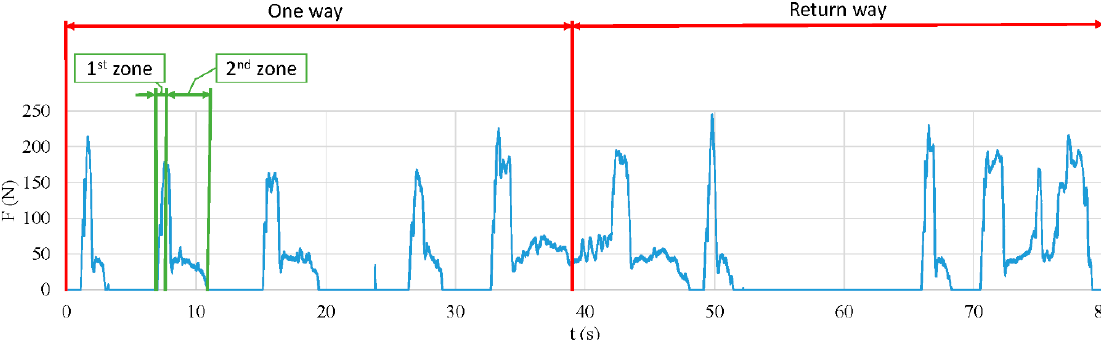
Figure 7. Examples of the limb angles of one volunteer. ( a ): Ankle, ( b ): Shoulder, ( c ): Neck, ( d ): Wrist, ( e ): Knee, ( f ): Trunk.